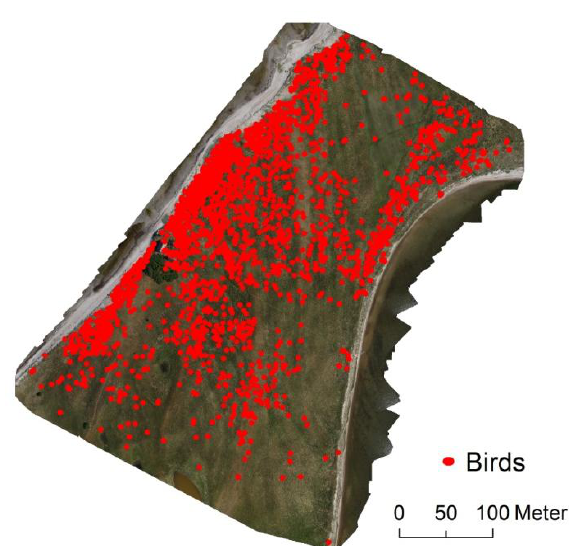
Figure 3. Identified bird objects (red dots) from UAS aerial survey of 25.5.2012 on the birds reserve island